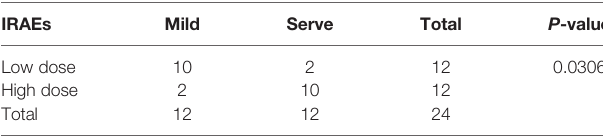
TABLE 3 | Evaluating the IRAEs under the treatment of ipilimumab.